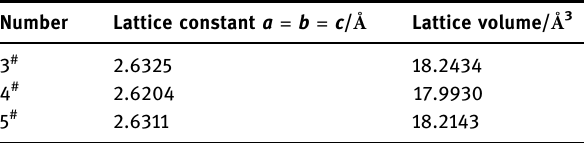
Table 6: Lattice parameters of the product Fe after the third - reduction stage